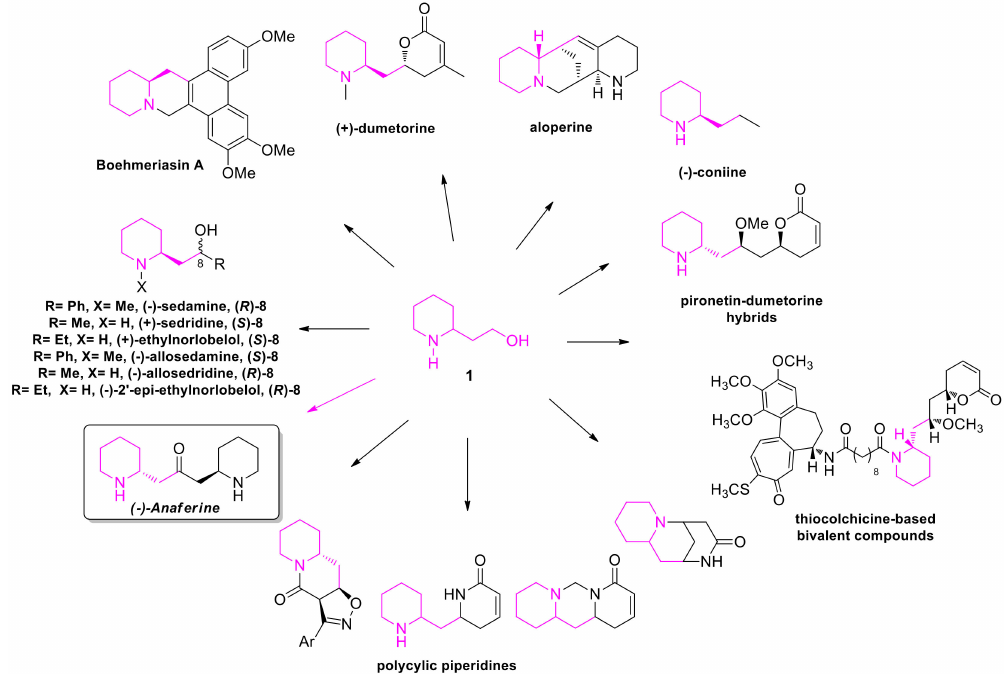
Figure 2. Structures of the representative members of our piperidine-based library, obtained through the DOS approach starting from 2-piperidine